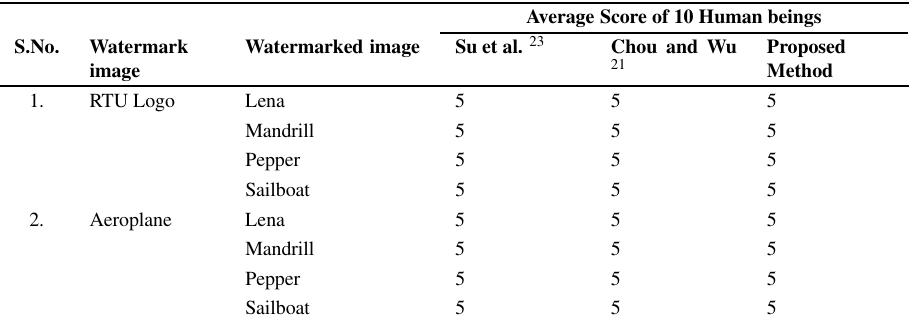
Table 2: Average subjective quality comparison of original and watermarked images by 10 human beings in the scale of 0 to